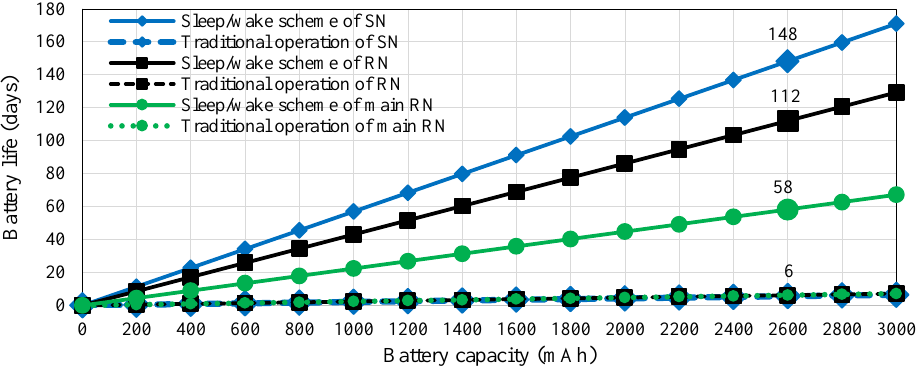
Figure 14. Estimated battery life versus battery capacity in the WAS based on the sleep/wake scheme and in the traditional operation.